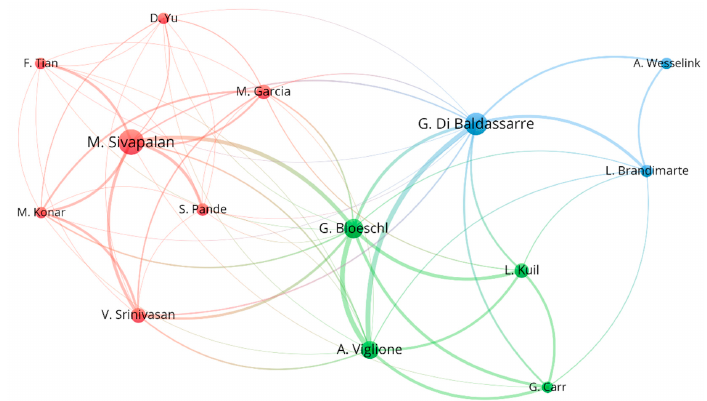
Figure 2. Co-authorship network based on the selected 180 papers. Only authors with at least 6 socio-hydrology papers are shown. Size of nodes corresponds to the number of papers written by an author. Thickness of a link between two authors corresponds to the number of papers they have co-authored. The network was plotted with VOSviewer [18,19] using bibliographic records extracted from WoS.